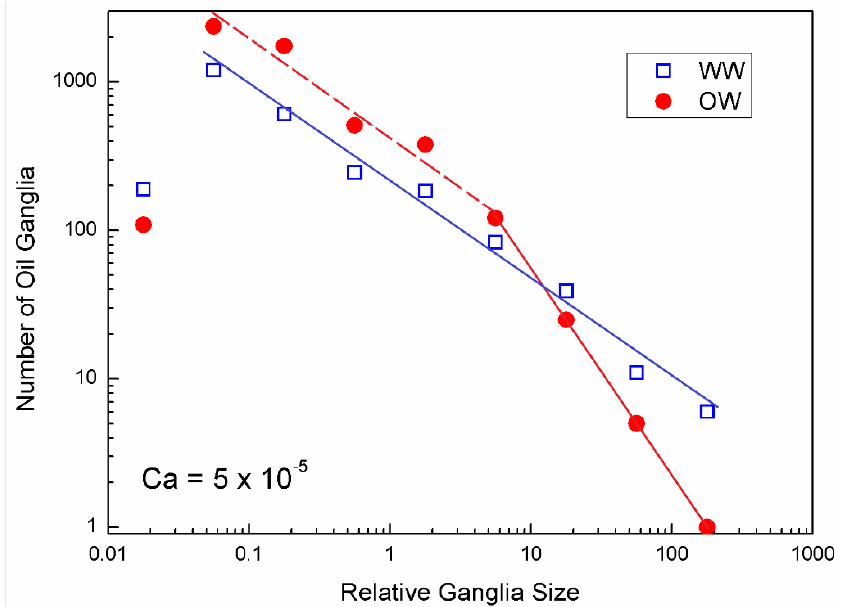
Figure 12. Ganglia size distribution at Ca = 5 × 10 − 5 for the water-wet and oil-wet porous media.